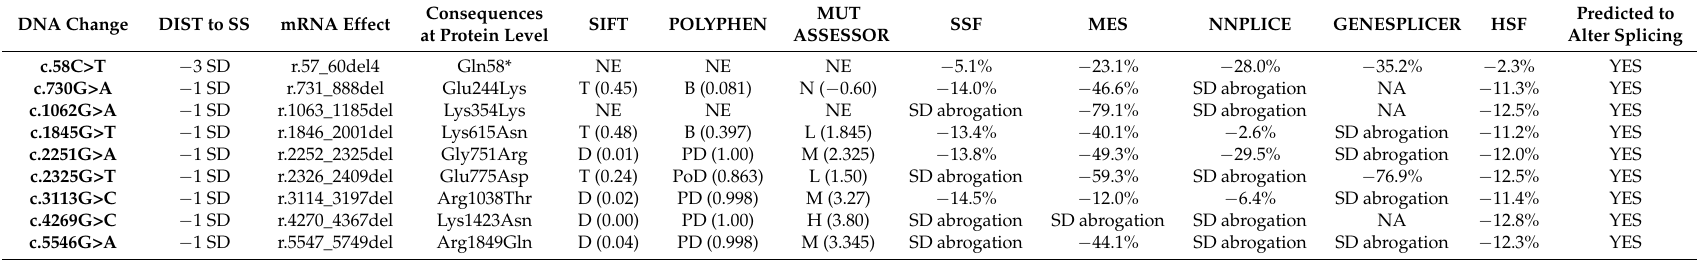
Table 3. Evaluation of mutations demonstrated to disrupt splicing in vivo by Pros et al. [12], with the five predictors from the Alamut Visual splicing module.